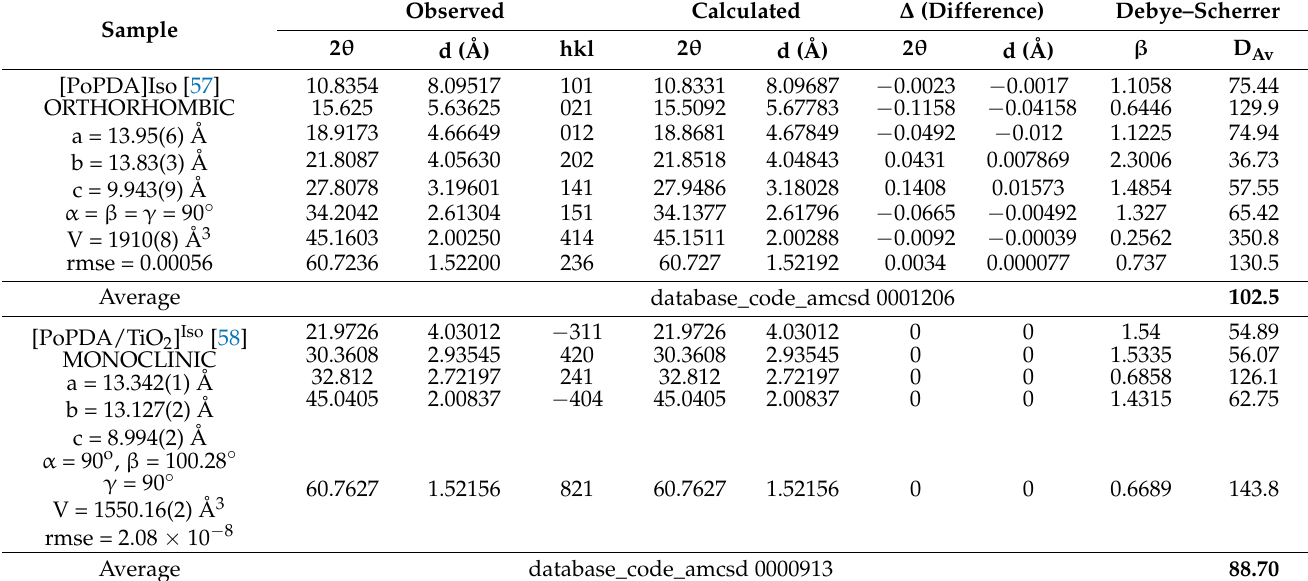
Table 1. The experimental and calculated XRD data using the Refine Version 3.0 Software Program (Kurt Barthelme’s and Bob Downs) for [PoPDA] TF and [PoPDA/TiO 2 ] MNC